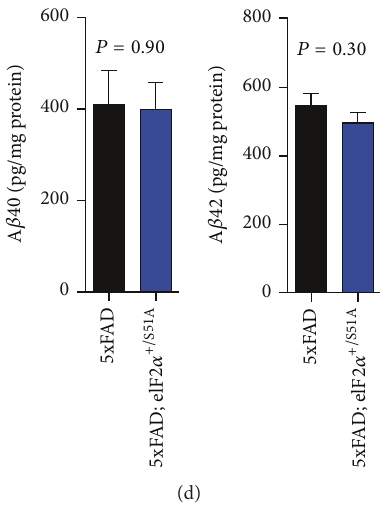
Figure 1: The 𝑒𝐼𝐹2𝛼 S 51 A mutation had no measurable effects on eIF2 𝛼 phosphorylation and APP processing. Shown are representative immunoblots of (a) p-eIF2 𝛼 and total eIF2 𝛼 , (b) human APP and total APP, and (c) 𝛼 -CTF and 𝛽 -CTF all prepared from hippocampal homogenates, along with the respective quantitative densitometric data (WT, 𝑛 = 6 mice; 5xFAD, 𝑛 = 7 mice; 5xFAD; 𝑒𝐼𝐹2𝛼 S 51 A , 𝑛 = 6 mice; 𝑒𝐼𝐹2𝛼 S 51 A , 𝑛 = 5 mice). (d) Concentrations of abundant A 𝛽 -species, A 𝛽 40 and A 𝛽 42, in 5xFAD hippocampal homogenates were determined using ELISA (5xFAD, 𝑛 = 7 mice; 5xFAD; 𝑒𝐼𝐹2𝛼 S 51 A , 𝑛 = 6 mice). All data are presented as mean ± SEM. Data were analyzed using two-way ANOVAs with the between-subjects factors 5xFAD genotype/eIF2 𝛼 genotype (effect of 5xFAD transgenes; effect of eIF2 𝛼 genotype; 5xFAD × eIF2 𝛼 interaction) and 𝑡 -tests (5xFAD versus 5xFAD; 𝑒𝐼𝐹2𝛼 S 51 A ) as appropriate. Statistically significant differences ( 𝑃 < 0.05 ) are denoted by bold